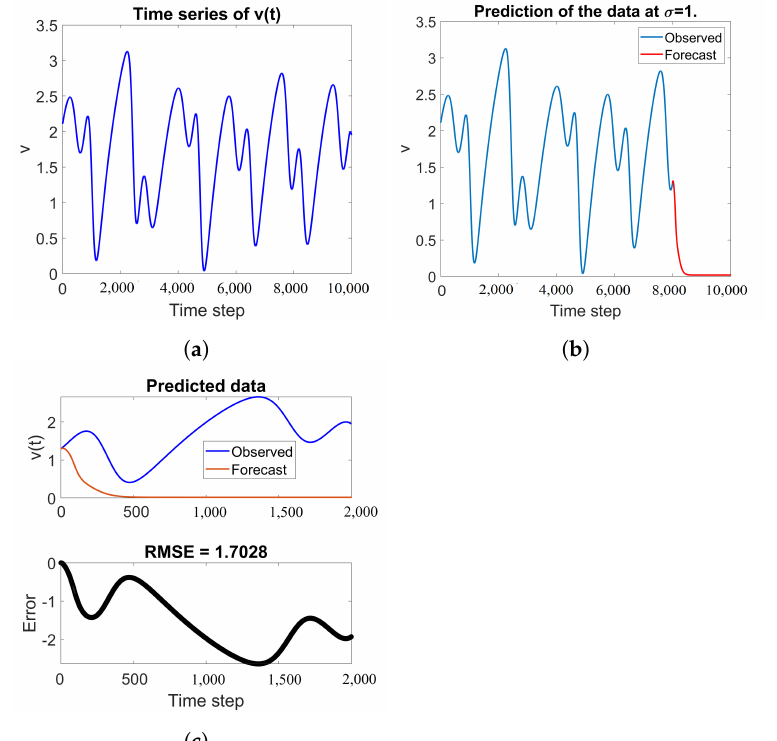
Figure 16. ( a ) The time series of v ( t ) of the model (1) obtained at σ = 1. ( b ) The prediction of time series using the LSTM method. ( c ) The predicted data and the error between observed and predicted time